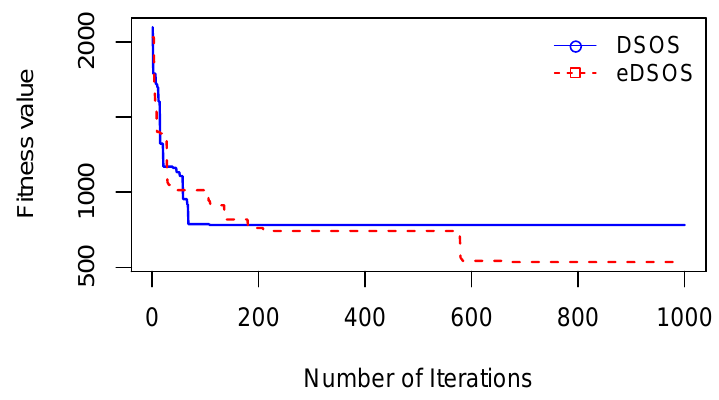
Figure 11. The convergence curves with 100 instances of tasks.